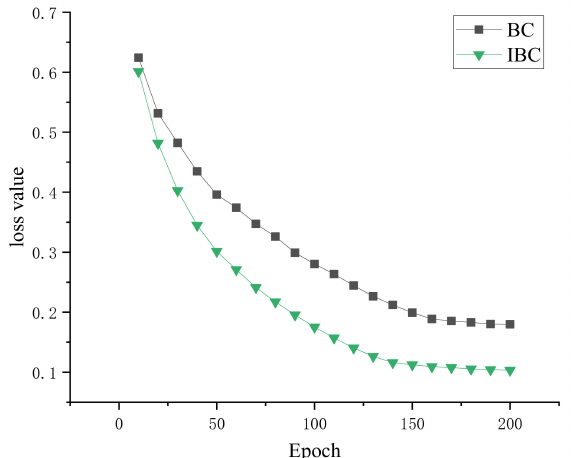
Figure 6. Loss variation curve. BC denotes the binary cross-entropy loss function, and IBC denotes the improved loss